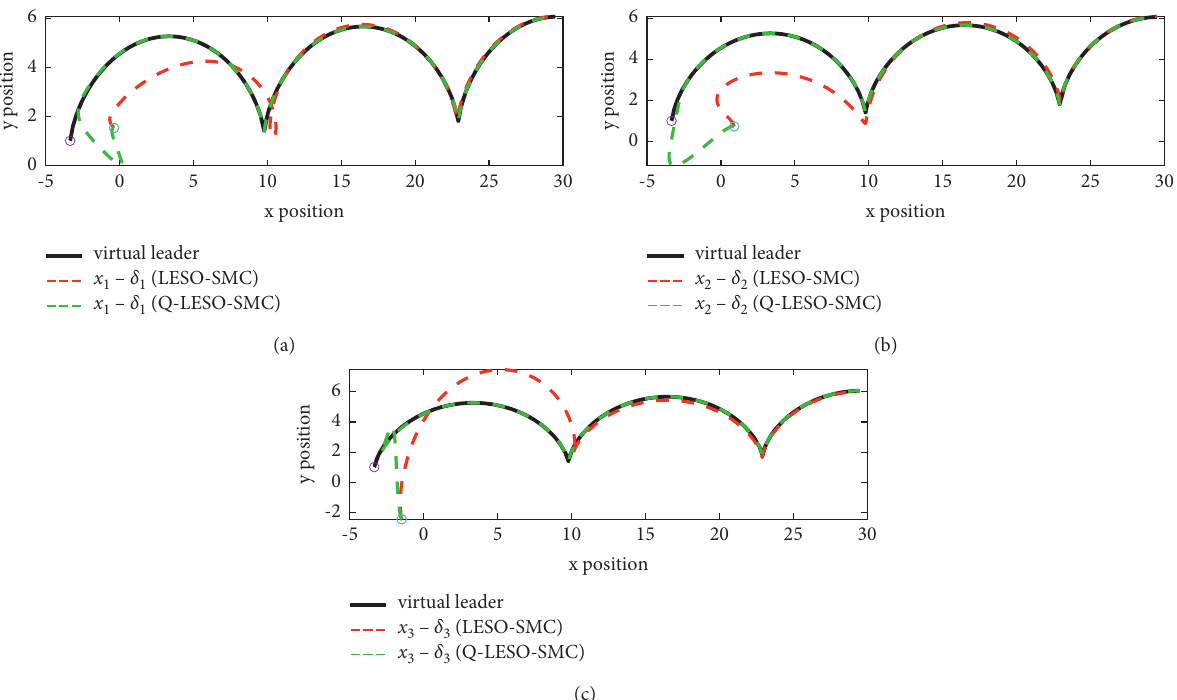
Figure 16: The tracking trajectories of the three followers and the virtual leader in Case B(a) The tracking trajectories of the 1st follower for the virtual leader. (b) The tracking trajectories of the 2nd follower for the virtual leader. (c) The tracking trajectories of the 3rd follower for the virtual